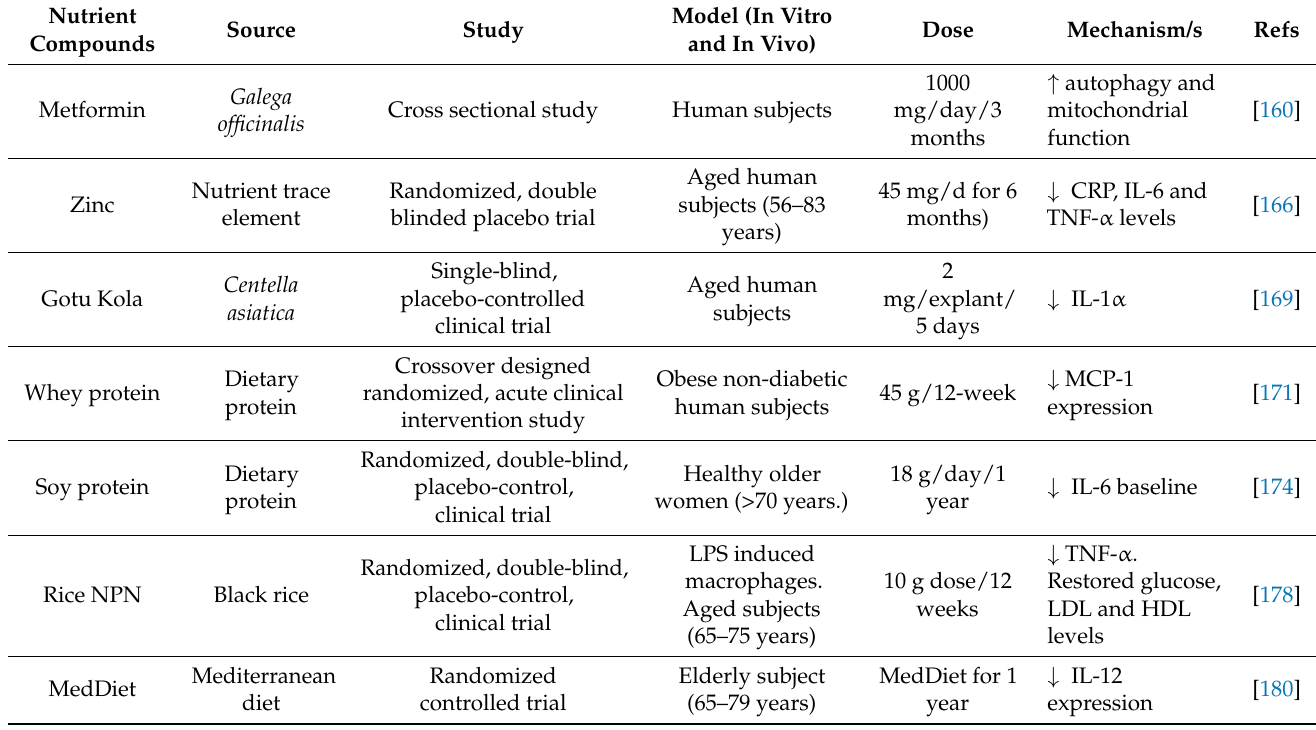
Table 2. List of selected nutrient compounds with clinical trials and human research targeting